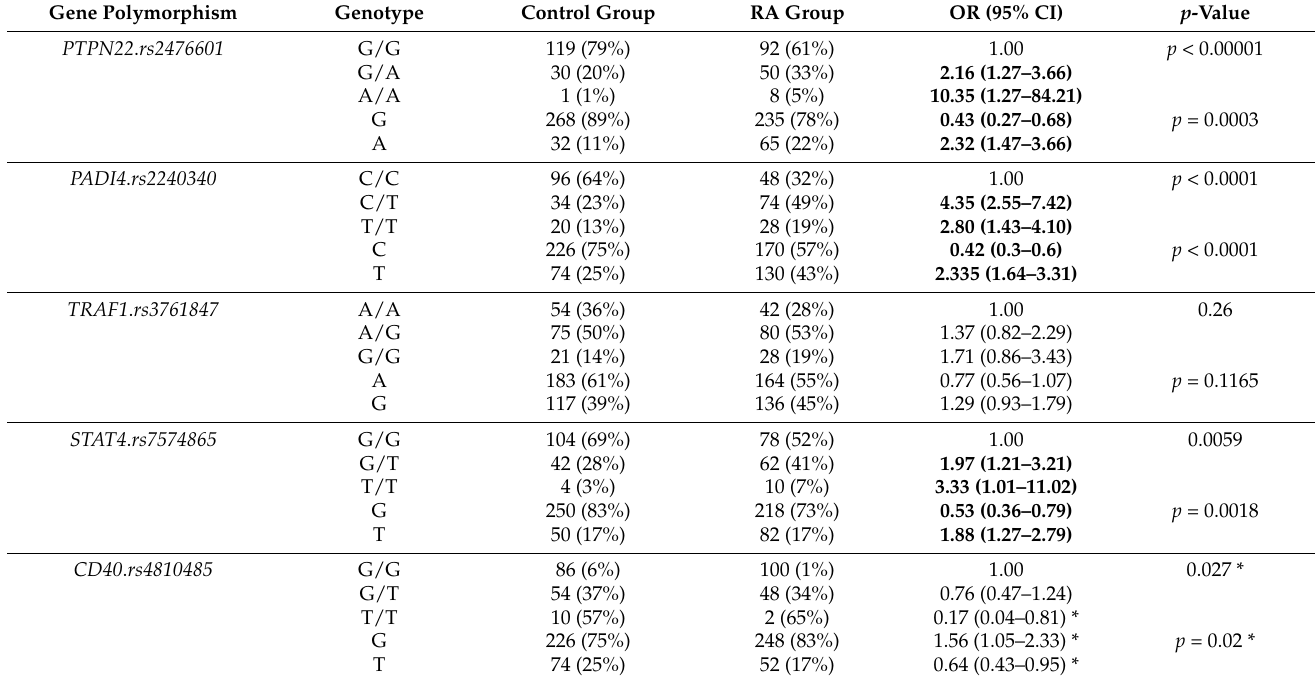
Table 4. Association of RA with the frequency of genotypes of the PTPN22 , PADI4 , TRAF1 , STAT4, and CD40 genes.